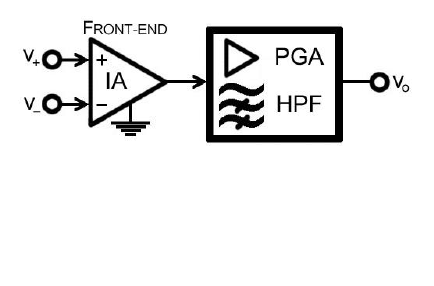
Figure 1. PGA stage supported by a previous IA front-end.